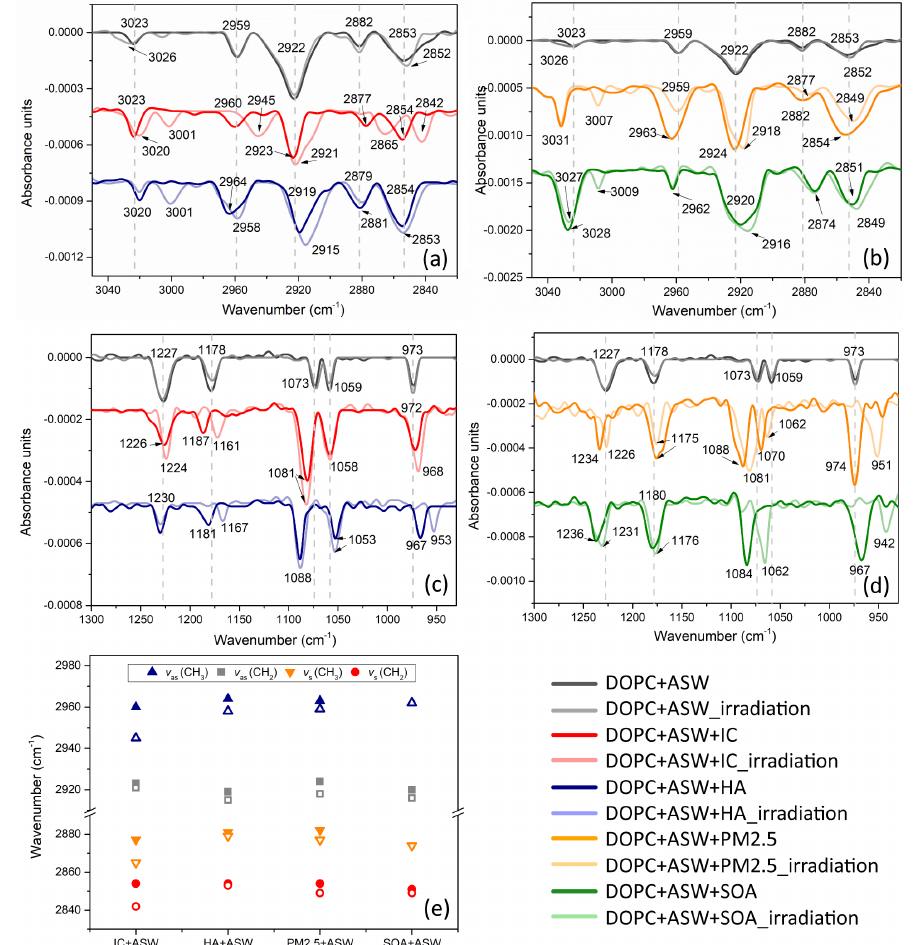
Figure 5. PM-IRRAS spectra of irradiated and non-irradiated DOPC monolayers in the range of (a) 2820–3050cm − 1 and (c) 930– 1300cm − 1 on the artificial seawater containing IC or HA. PM-IRRAS spectra of irradiated and non-irradiated DOPC monolayers in the range of (b) 2820–3050cm − 1 and (d) 930–1300cm − 1 on the artificial seawater containing PM 2 . 5 or the SOA sample. (e) The frequencies of antisymmetric and symmetric stretching methylene (CH 2 ) and methyl (CH 3 ) vibrations for the DOPC monolayer on the artificial seawater mixed with IC, HA, PM 2 . 5 , or the SOA sample. IRRAS spectra were recorded at 25mNm − 1 . (Solid shapes: no irradiation exposure; open shapes: irradiation